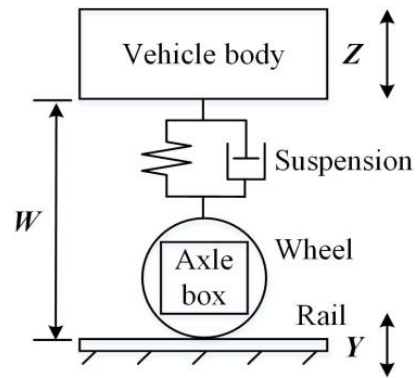
Figure 2. Sketch of inertial reference method.